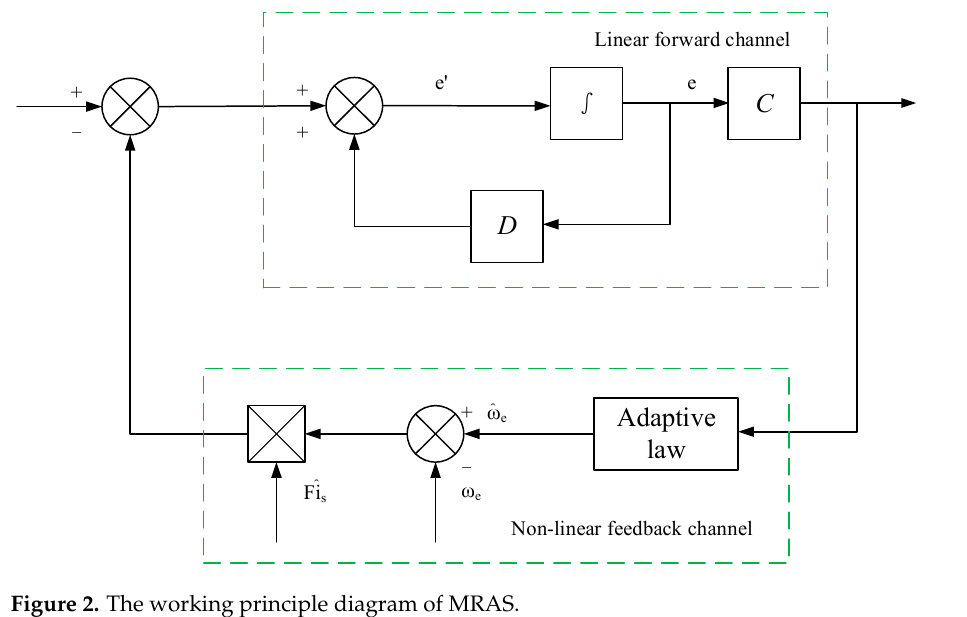
Figure 2. The working principle diagram of MRAS. In this diagram, D = e = i ∗ − ˆ i ∗ , * means the variable’s real value.